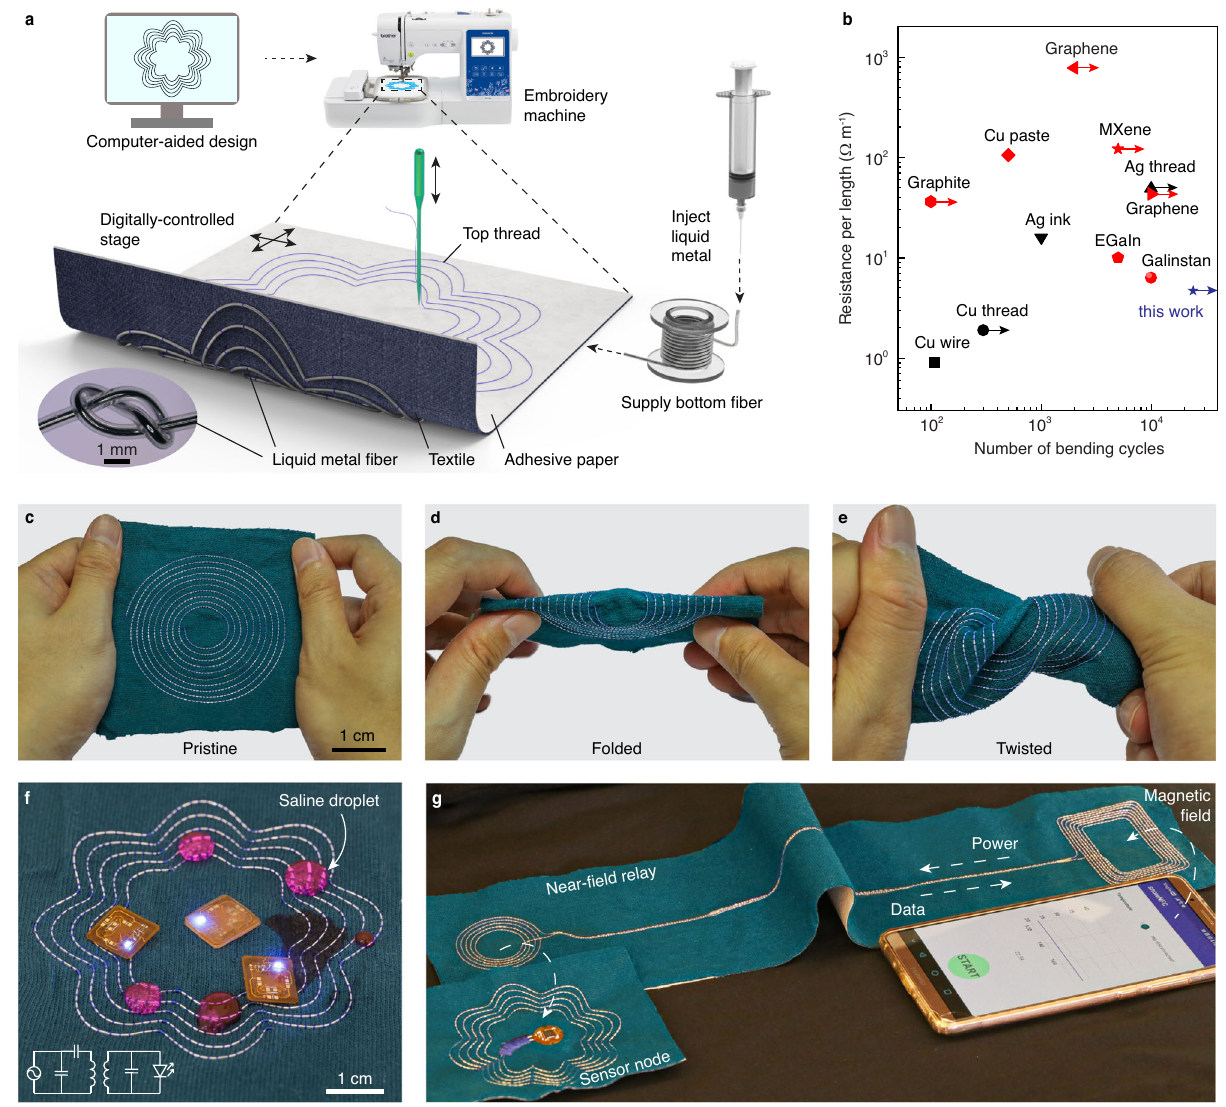
Fig. 1 Digital embroidery of liquid metal wireless systems. a Illustration of the digital embroidery process. Liquid metal fi bers consist of per fl uoroalkoxy alkane tubing in fi ltrated with galinstan. b Electrical resistance per length and mechanical robustness of the liquid metal fi bers compared to conductive materials used for textile (black color) or fl exible (red color) electronics. Mechanical robustness is measured by the tested number of bending cycles. Arrows indicate materials have 10% resistance change happened after the maximum tested cycle. c – e Images of embroidered textiles subjected to folding and twisting. f Image of an embroidered spiral inductor wirelessly powering light-emitting devices in the presence of saline droplets. g Embroidered wireless system comprising a relay for long-range near- fi eld communication between a smartphone and textile sensor (Supplementary Fig. 6). Beyond functioning as passive relays, the digitally embroidered textiles can also incorporate NFC chips to create clothing with system-level wireless sensing and data transfer capabilities. For example, the NFC antenna — which represents the largest component of the system — can be digitally embroidered onto the textile substrate, while the NFC chip and associated discrete components are assembled on a 1.3-cm